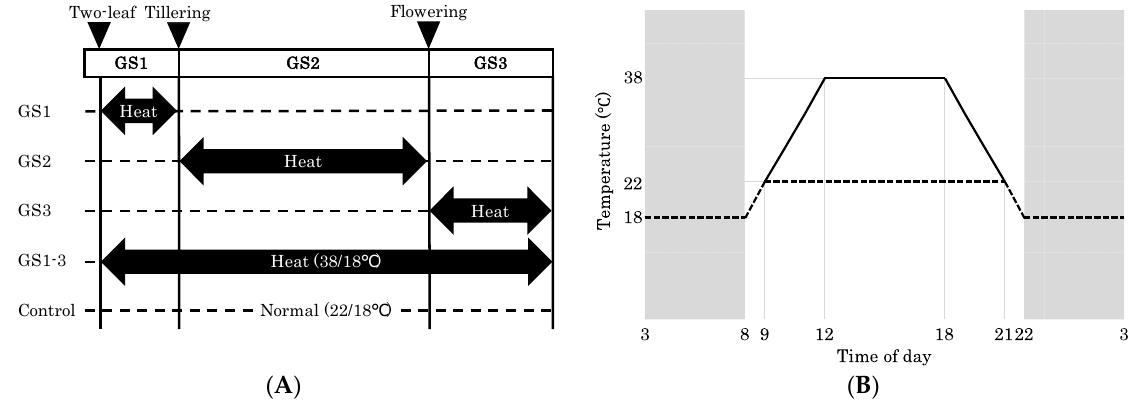
Figure 1. Outline of heat stress experiment. Wheat plants were kept at 22 °C day/18 °C night (Normal, Control) or exposed to transient high temperature (Heat) at 38/18 °C at each growth stage. ( A ) Arrows indicate the high-temperature treatment and dashed lines indicate normal growth conditions. ( B ) Daily temperature variation. White background, day; gray, night.